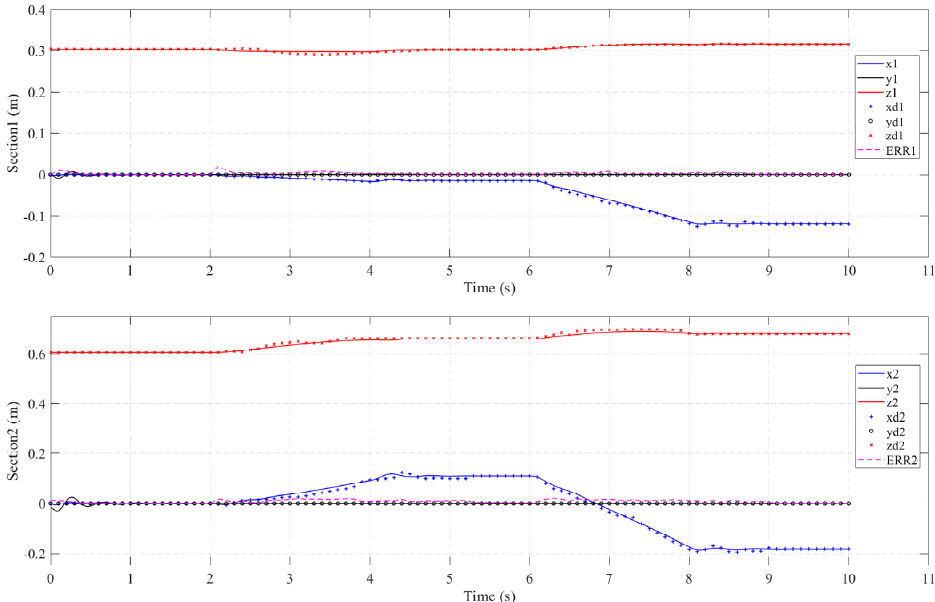
Figure 14. Sequential planar bending of all the sections. Comparison of the dynamic section tip coordinate evolution (solid line) vs. the corresponding coordinate values of the prototype arm (X, Y, and Z experimental data are denoted by o, +, and × marks, respectively). Position errors, ERR i = || ψ ie - ψ i || ∀ i ϵ {1,2}, are denoted by a dashed line in each subplot.